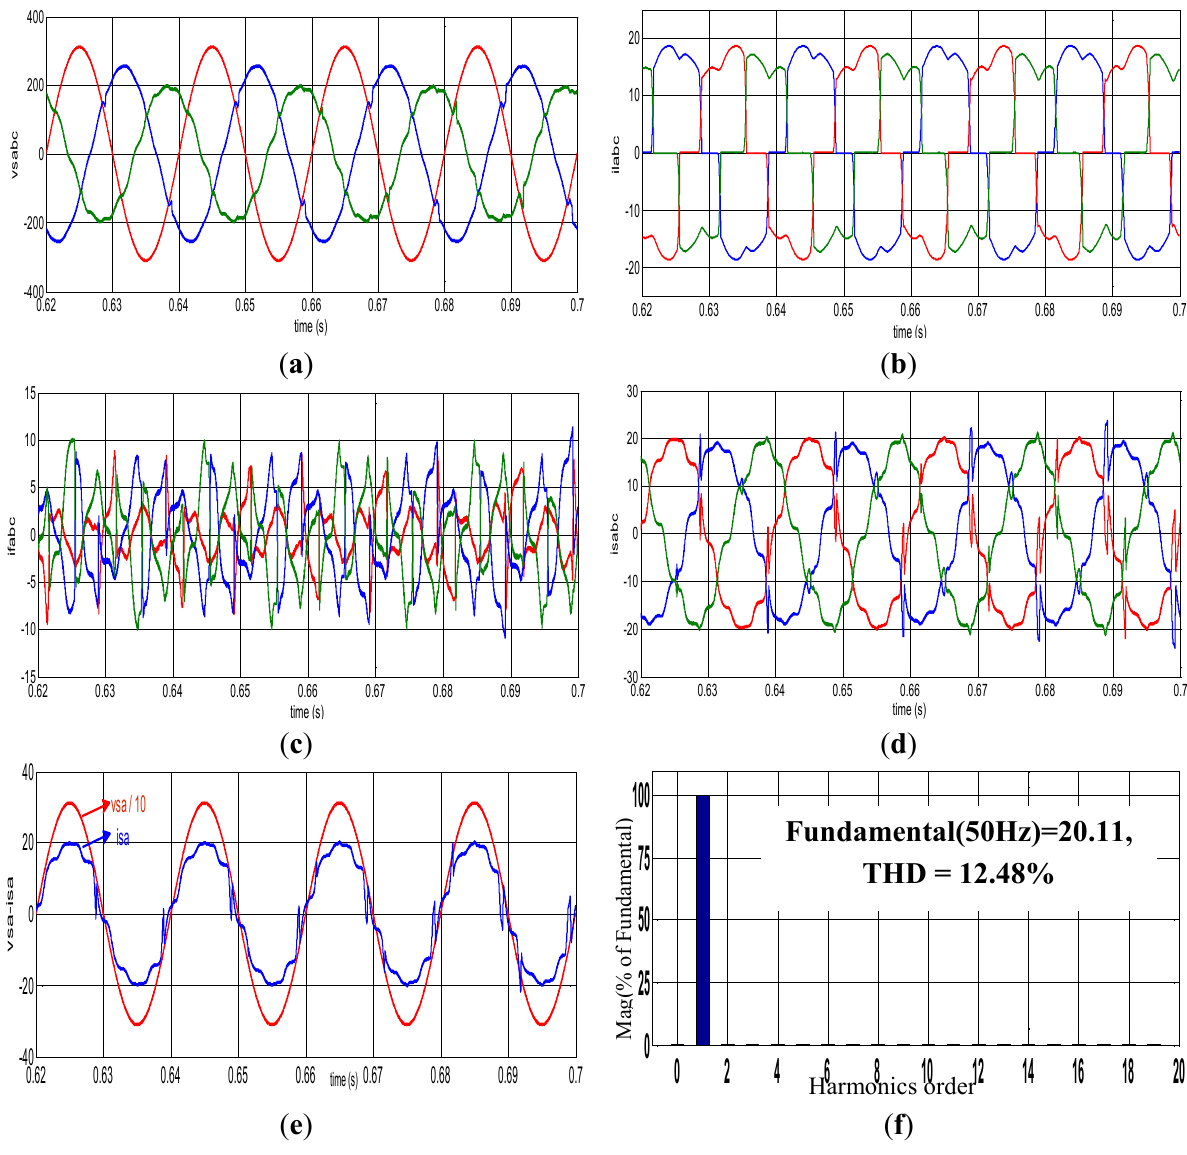
Figure 9. Simulation results for unbalanced sinusoidal grid voltage: ( a ) three-phase line voltages; ( b ) three-phase load currents; ( c ) three-phase filter currents; ( d ) three-phase line currents; ( e ) line voltage and current, phase-a; ( f ) frequency spectrum of line current,